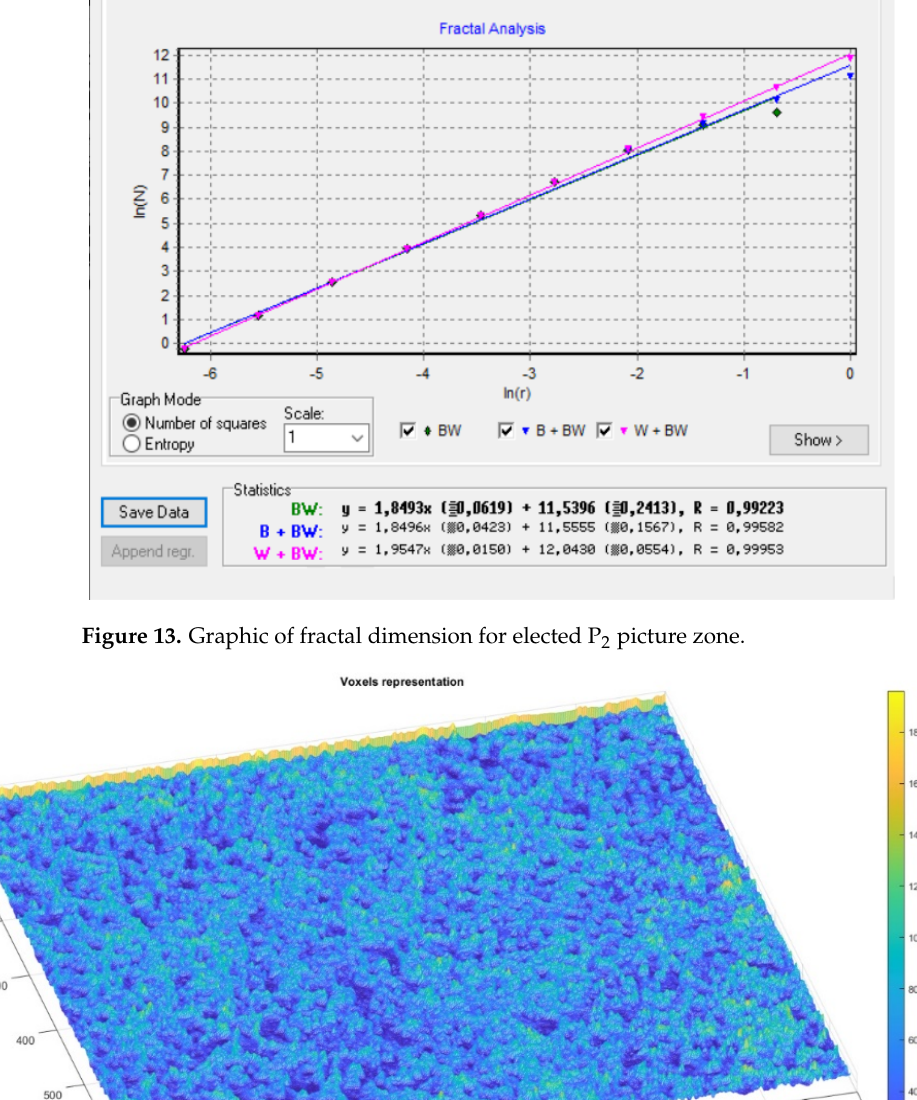
Figure 14. Three ‐ dimensional voxel representation of P 2 image. Figure 14. Three-dimensional voxel representation of P 2